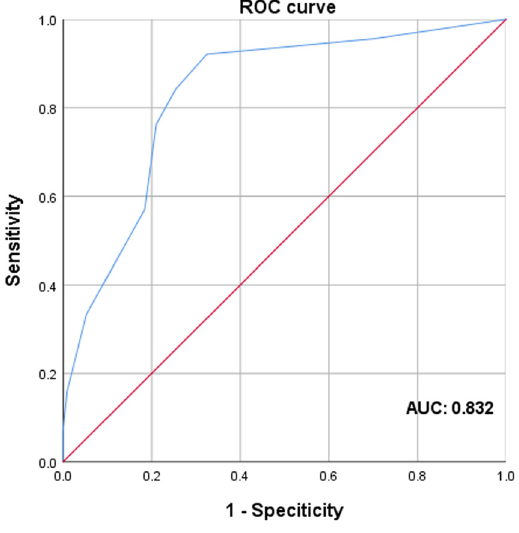
Figure 5: ROC curve analysis to detect the predictive value of TRIM28 in BC